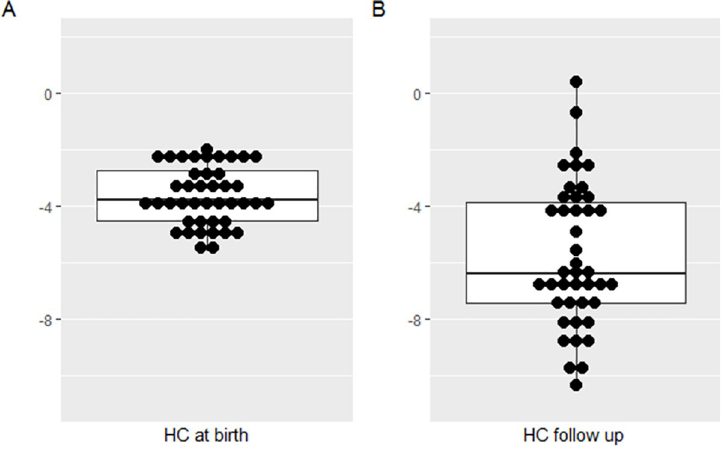
Fig 1. Head circumference of children with Congenital Zika Syndrome-associated microcephaly. Comparison of A) Z-score at birth (INTERGROWTH-21 parameters and B) Z-score at follow up (WHO parameters). The two children with HC Z-score > -2 SD at follow up both had a history of hydrocephalus.